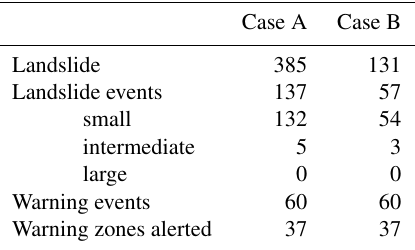
Table 4. Number of landslides, landslides, warning events issued and warning zones alerted in 2013–2014 in the area of analysis.